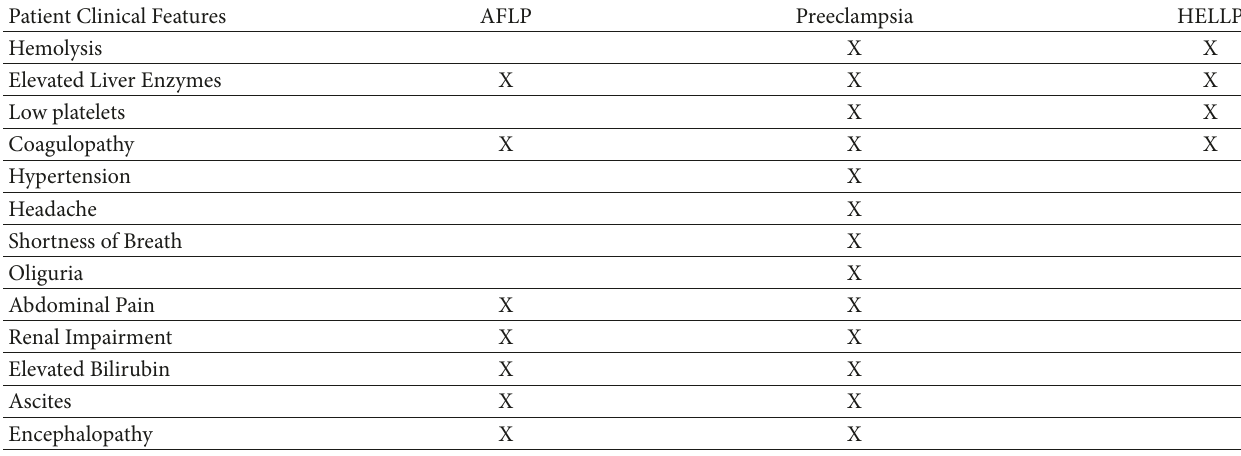
Table 2: Patient Clinical Features of AFLP, Preeclampsia, and HELLP